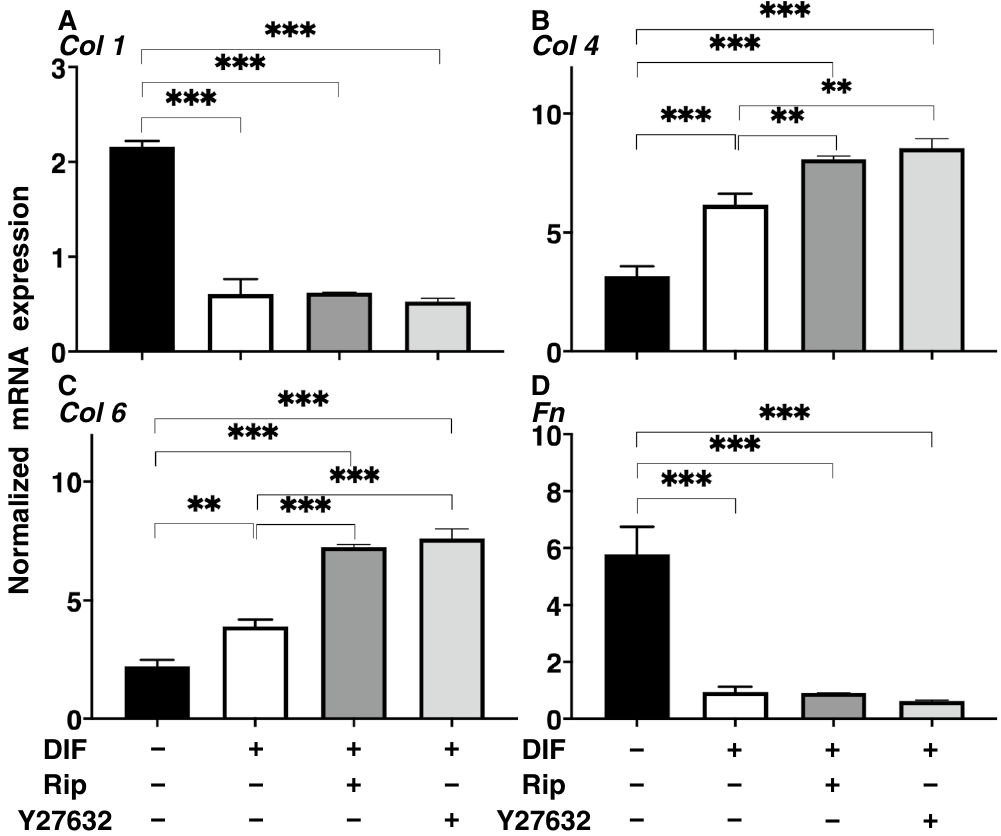
Figure 6. mRNA expression of ECMs in 3T3-L1 3D organoids under several conditions. At Day 7, the 3T3-L1 3D organoids of preadipocytes (DIF−) and their adipogenic differentiation (DIF+) without or with 10 µM Ripasudil (Rip) or Y27632 were subjected to a qPCR analysis to estimate the mRNA expression of ECMs ( Col1 : collagen 1, Col4 : collagen 4, Col6 : collagen 6, Fn : fibronectin). All experiments were performed in duplicate using fresh preparations, each of which consisted of 16 organoids. Data are presented as arithmetic means ± standard error of the mean (SEM). **P < 0.01, ***P < 0.005, and other pairs were not statistically significant (ANOVA followed by a Tukey’s multiple comparison